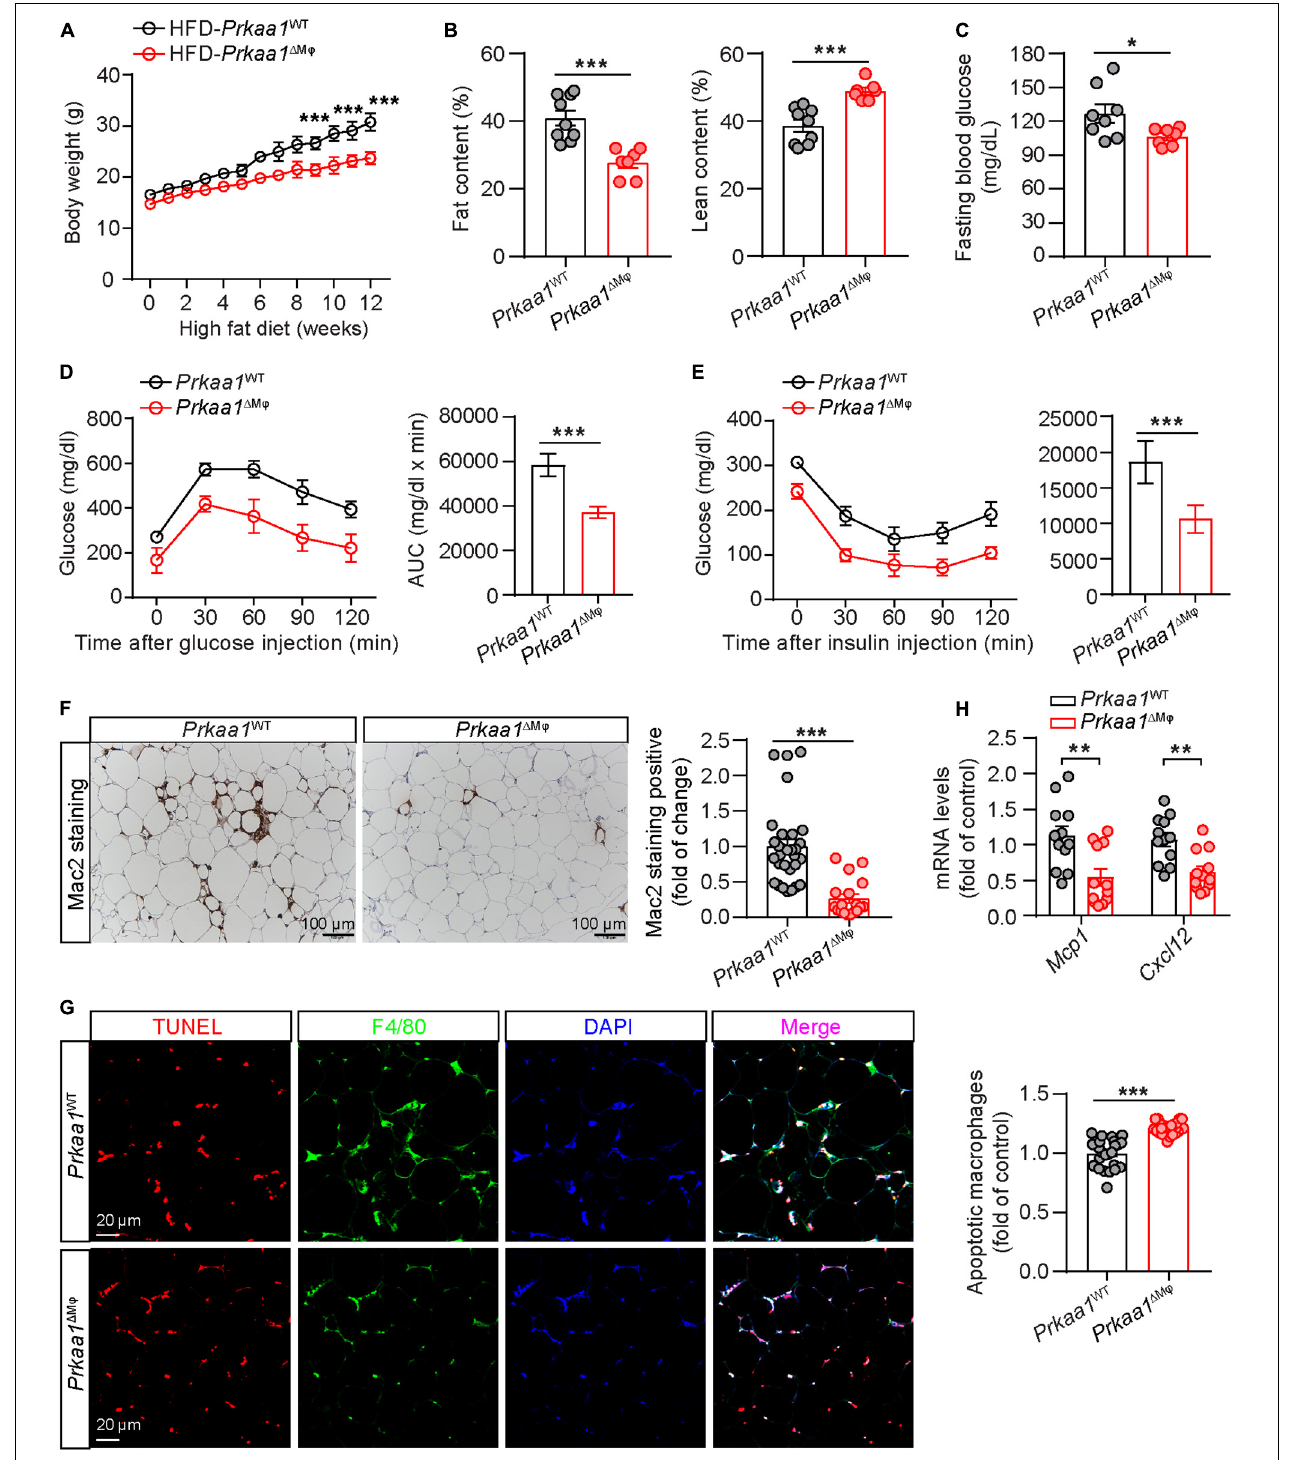
FIGURE 4 | Myeloid Prkaa1 deficiency protects mice from HFD-induced insulin resistance. (A) Body weight of Prkaa1 WT and Prkaa1 (cid:49) M ϕ male mice during 12 weeks of HFD feeding. n = 9. (B) Fat and lean content of Prkaa1 WT and Prkaa1 (cid:49) M ϕ male mice after being fed HFD for 12 weeks. n = 9. (C) Fasting blood glucose levels of Prkaa1 WT and Prkaa1 (cid:49) M ϕ male mice after being fed HFD for 12 weeks. n = 8. (D) Blood glucose levels (left) and AUC (area under the curve, right) during GTT (glucose tolerance test) in Prkaa1 WT and Prkaa1 (cid:49) M ϕ male mice after being fed HFD for 10 weeks. n = 6. Mice were fasted for 16 h and injected with glucose (2 g/kg IP). (E) Blood glucose levels (left) and AUC (right) during ITT (insulin tolerance test) in Prkaa1 WT and Prkaa1 (cid:49) M ϕ male mice after being fed HFD for 11 weeks. n = 6.